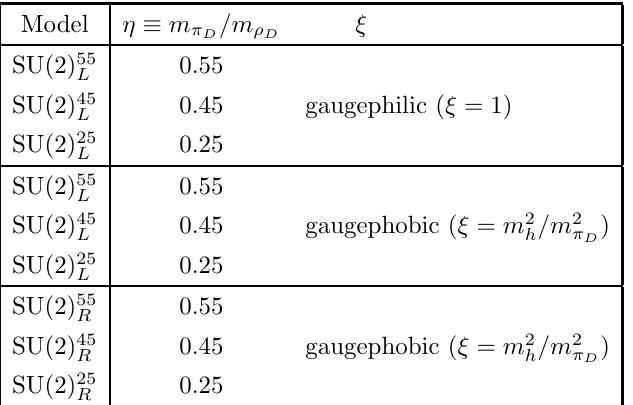
Table 1 . Benchmark models and parameters used in our study. Note that the gaugephilic case only occurs for the SU(2) L model, as discussed in section 2 in the